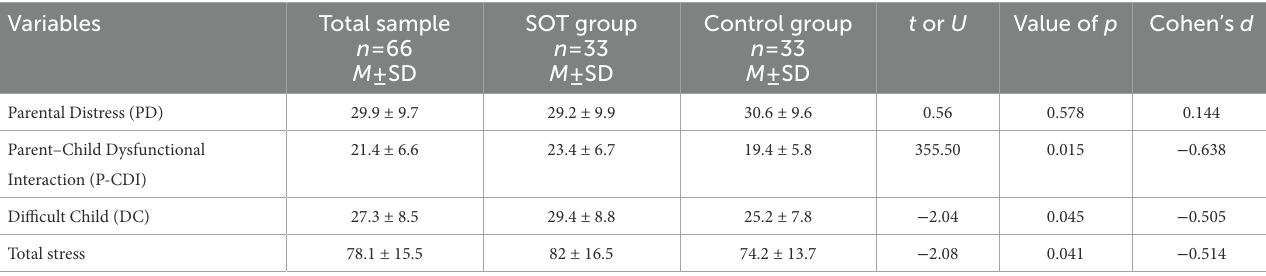
TABLE 2 Parenting Stress Index-Short Form (PSI-SF).